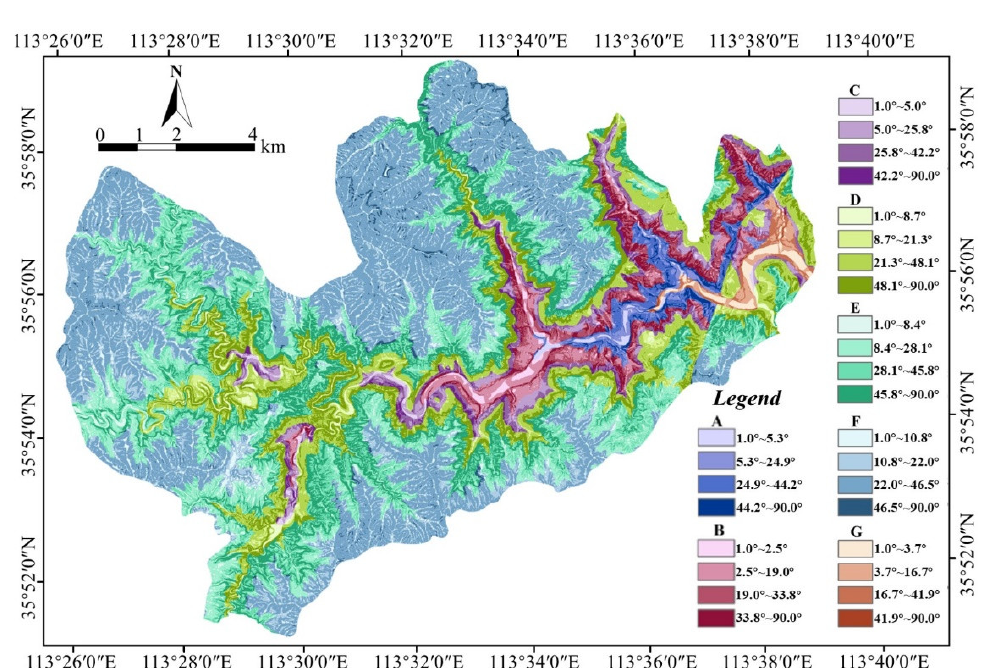
Figure 12. Classification scheme of the main HMAs in the study